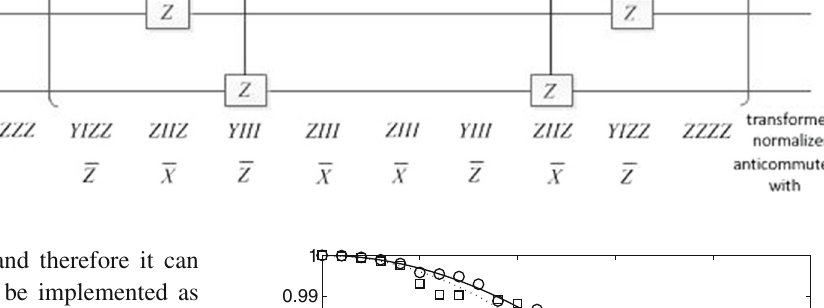
Fig. 3 Fault-tolerant circuit for the Q 2 X subgroup, where the transformed ¯ Z is shown at each gate, and directly below the original normalizer element with which it anticommutes